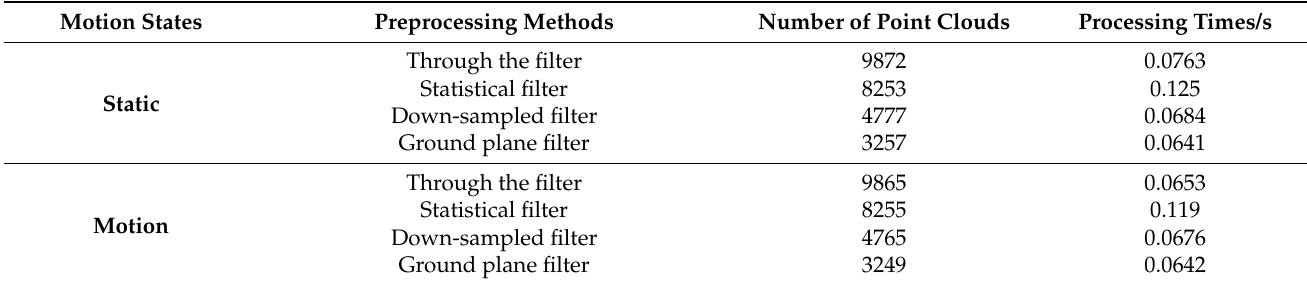
Table 2. Cowshed point cloud preprocessing results.